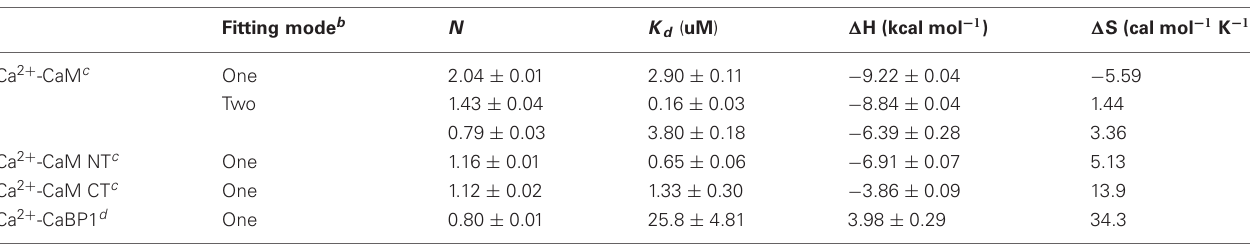
Table 1 | Isothermal titration calorimetry data a